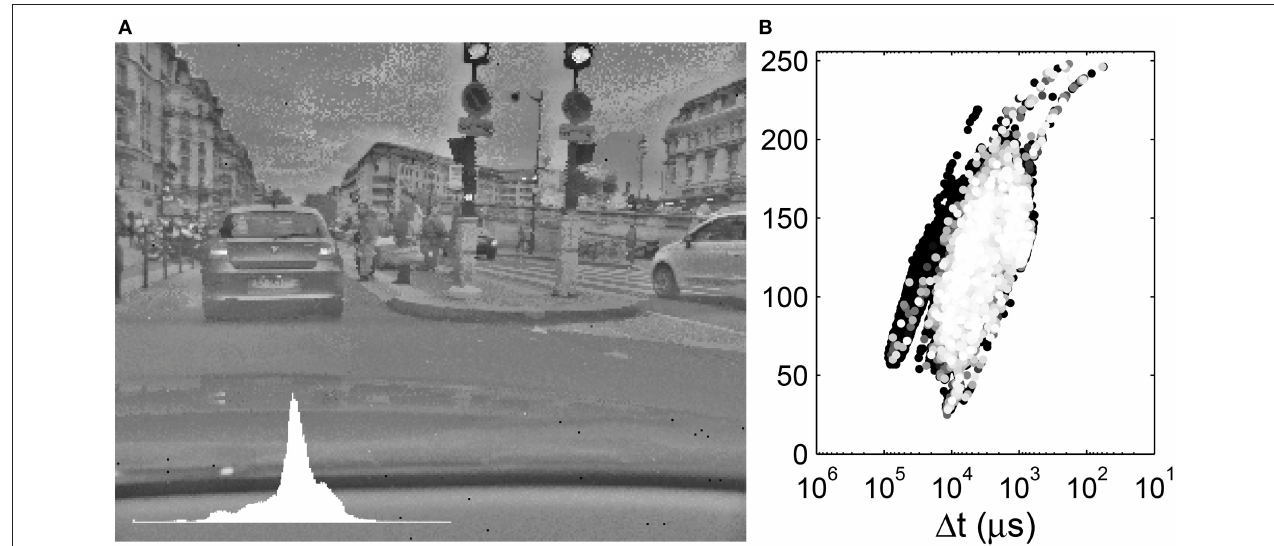
FIGURE 6 | (A) Local tone mapping with R = 10. Inset: Image histogram. (B) Display values as a function of the input time differences. The input time differences are plotted on an inverse logarithmic scale while the output gray-levels are plotted linearly. The 10% most recent events are colored with a gray-level.